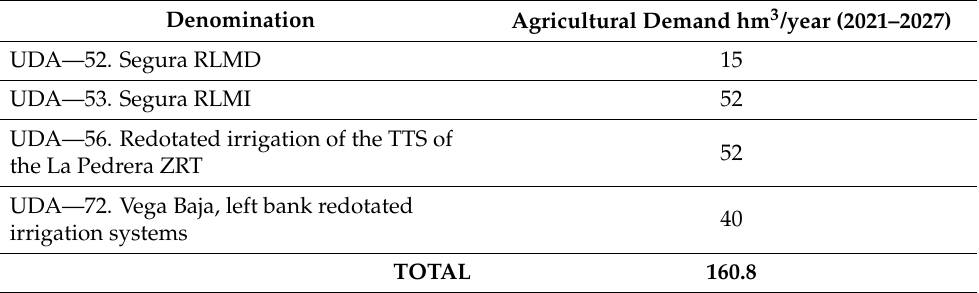
Table 10. Agricultural demand that takes advantage of the waters of the TTS in the Vega Baja del